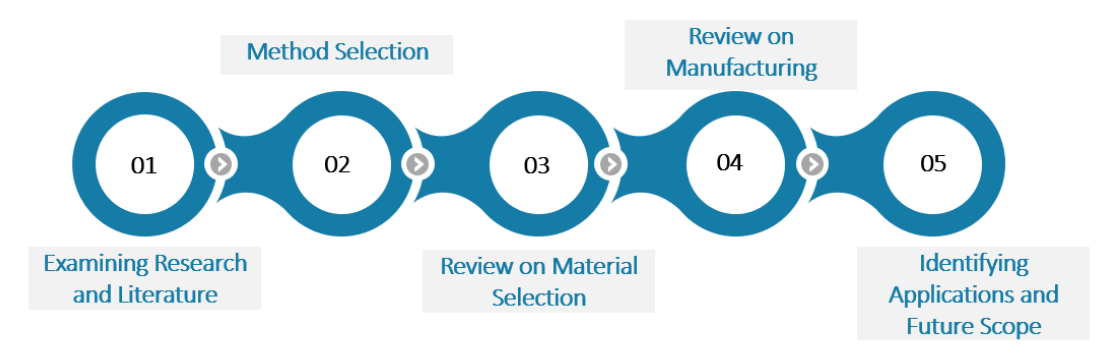
Figure 2. Methodology adopted in bio-inspired design review